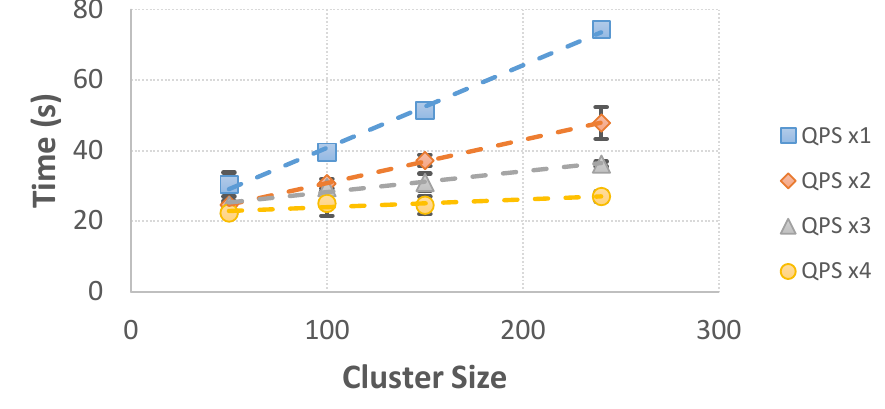
Fig. 1. Time to scale the pause container up to five replicas per node as a function of the cluster size. The plot reports the measured times for four different values of the QPS parameter